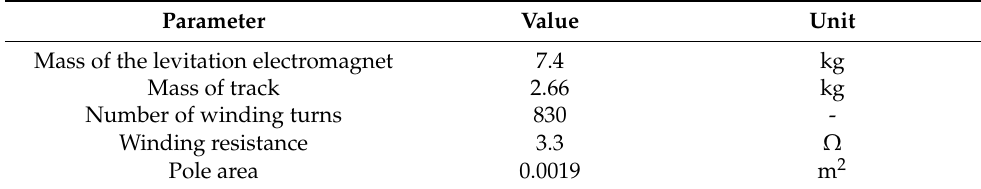
Figure 11. Basic structure of the magnetic suspension experimental platform. Table 2. Parameters of suspension experimental platform.